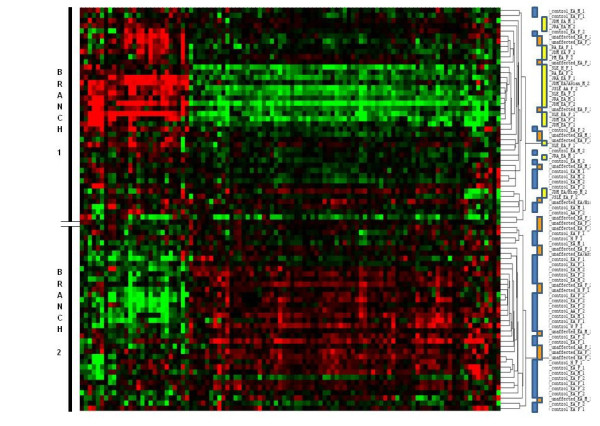
Heat map representing an unsupervised, hierarchical cluster analysis of the three study groups. The groups consisted of 20 probands with a systemic autoimmune disease, their 20 unaffected twins, and 40 unrelated, matched controls, respectively. The heat map uses 104 oligo probes that exhibited statistically significant differential gene expression (multiple comparison-adjusted P values (false discovery rate) of less than 0.1) between probands and unrelated, matched controls. Color codes to the immediate right of the dendrogram correspond to probands (yellow), unaffected twins (orange), and unrelated, matched controls (blue). The first major partition in the dendrogram (branches 1 and 2) is marked to the left of the heat map.